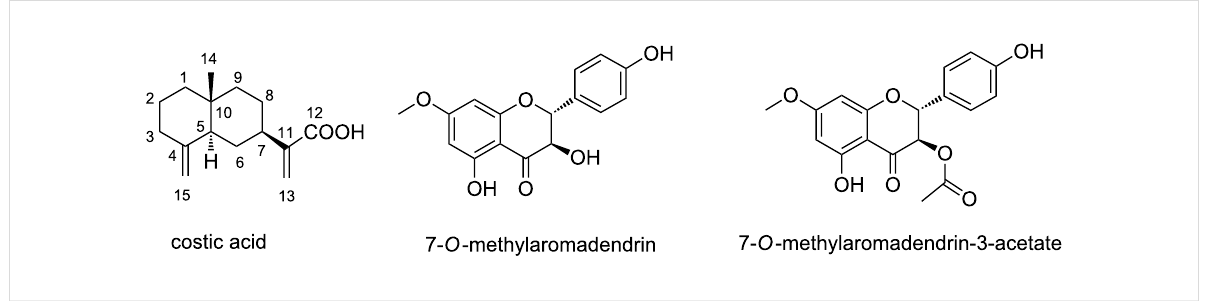
Figure 4: Structures of costic acid, 7-O-methylaromadendrin and 7-O-methylaromadendrin-3-acetate.